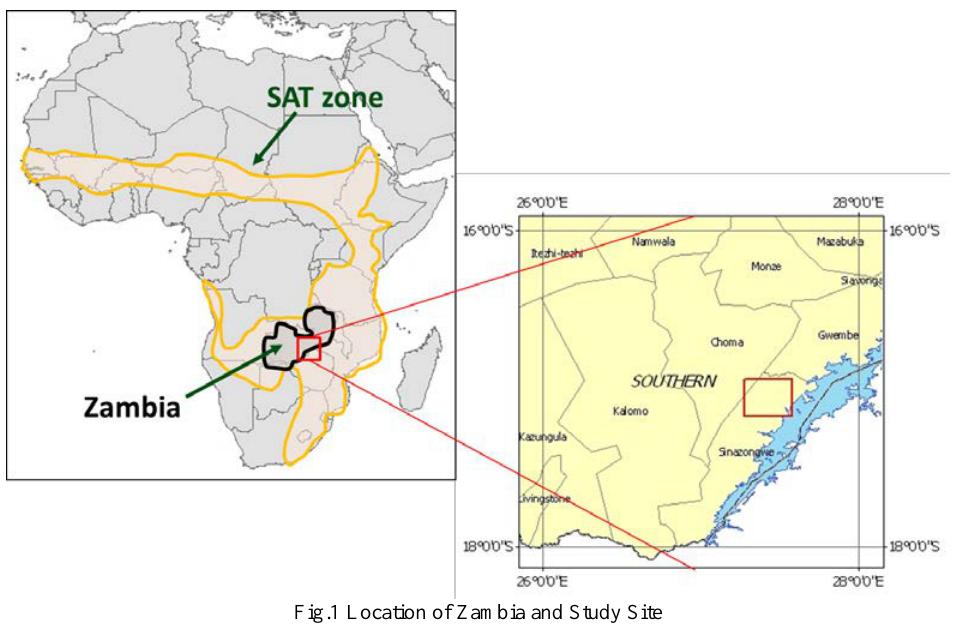
Fig.1 Location of Zambia and Study